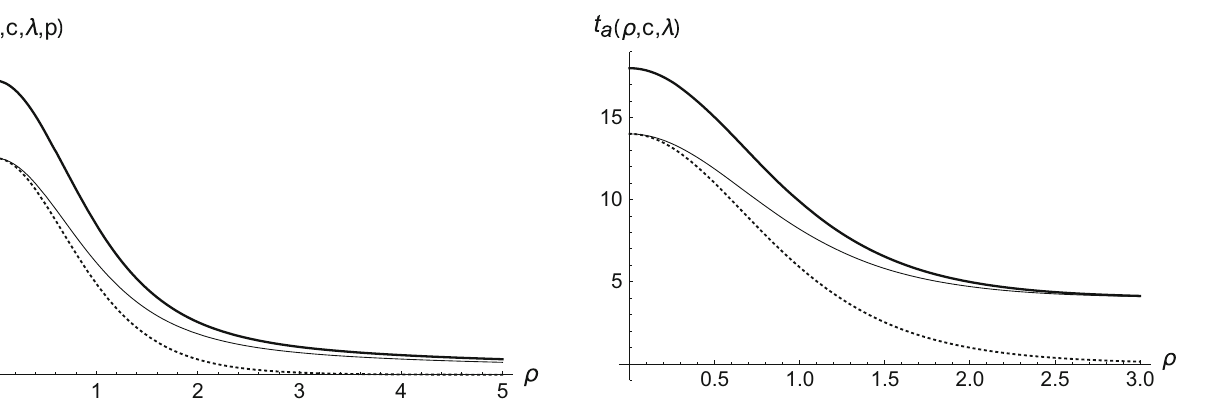
Fig. 7 Energy density (thick line), radial pressure (thin line) and angu- lar pressure (dotted line) for p = λ = 1 , c = 2